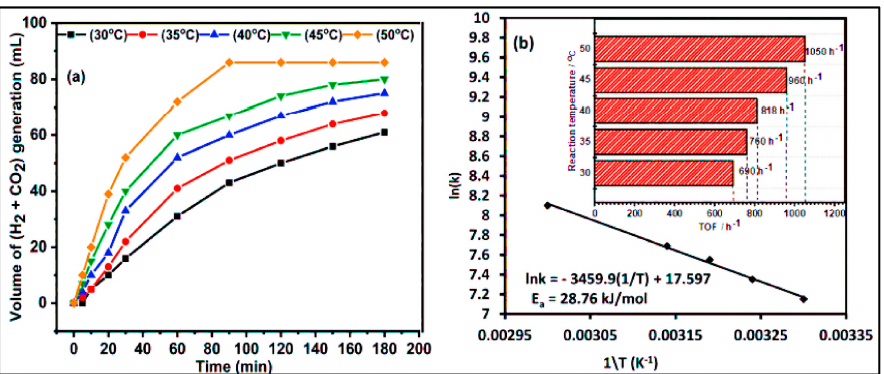
Figure 5. Volume of H 2 gas evolution from the aqueous FA solutin and the corresponding TOF: ( a ) Volume of (H 2 + CO 2 ) gas formed from formic acid decomposition vs. time, and ( b ) TOF of H 2 values produced with the Au 1 Pd 3 /rGO catalyst at (30–50 ◦ C). Reproduced from ref. [87] with permission from the Royal Society of